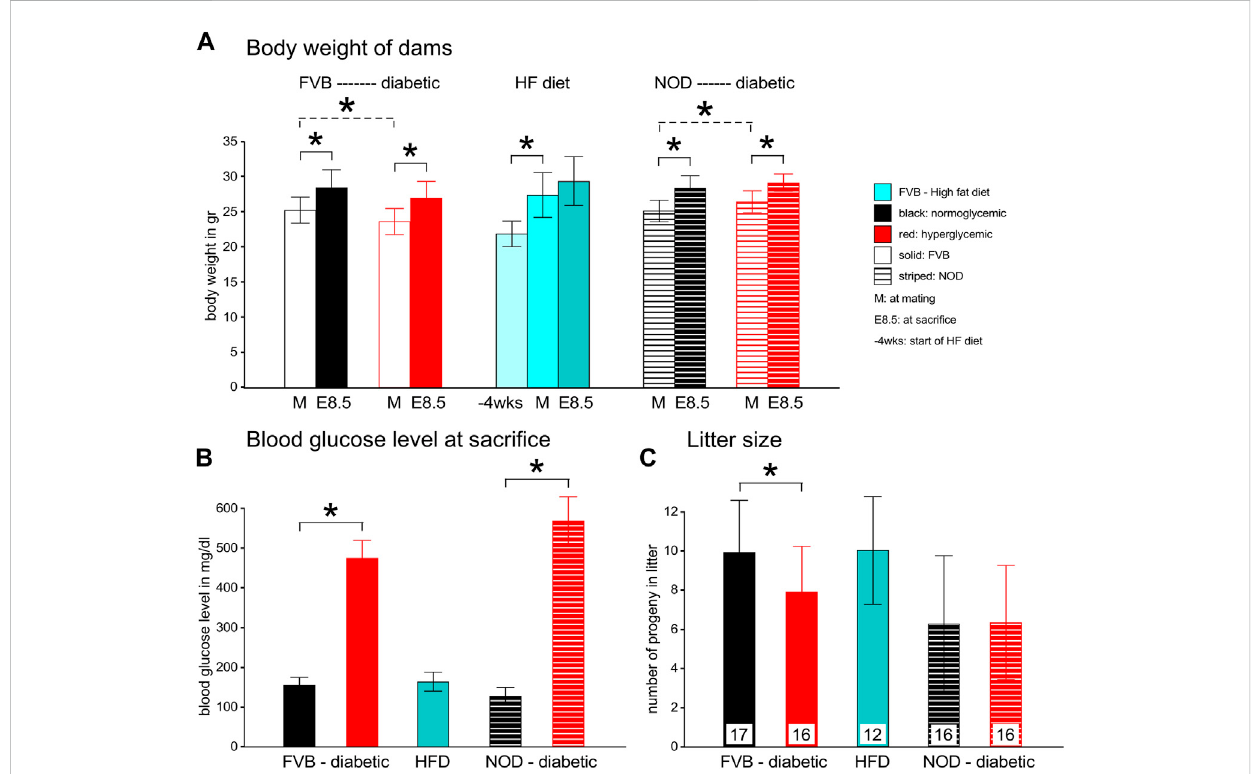
FIGURE 1 Maternal parameters in two experimental models of diabetic pregnancy and a mouse model of obesity in pregnancy. Panel A: FVB females entered the experiments at the age of 10 – 12 weeks, after diabetes induction by STZ, whereas NOD females were used between the ages of 12 – 17 weeks, depending on development of diabetes. FVB females with high-fat diet feeding entered the feeding stage at ~8 weeks of age, with matings performed at ~12 weeks of age. Maternal body weights were recorded at entry into the feeding phase, at mating and at sacri fi ce at gestational day E8.5. Diabetic cohortsarelabeledinred,FVBanimalsarerepresentedbysolidbars,NODmicebystripedbars.Panel B :BloodglucoselevelsweremeasuredinFVBdams before and after STZ-induction, and at mating and sacri fi ce. In NOD females, blood glucose levels were monitored weekly after the age of 12 weeks. Females were declared diabetic and mated when their blood glucose levels exceeded 250 mg/dl; their glucose levels increased further throughout the pregnancy. Glucose measurements on HFD-fed females were taken at mating and sacri fi ce, and remained normal throughout the pregnancy. Panel C : Litter sizes were reduced in FVB diabetic females, and remained unaffected by HFD and in the NOD strain. Number of pregnant females/group: FVB normoglycemic n = 17; FVB diabetic n = 16; FVB HFD: n = 12; NOD normoglycemic n = 16; NOD diabetic n =